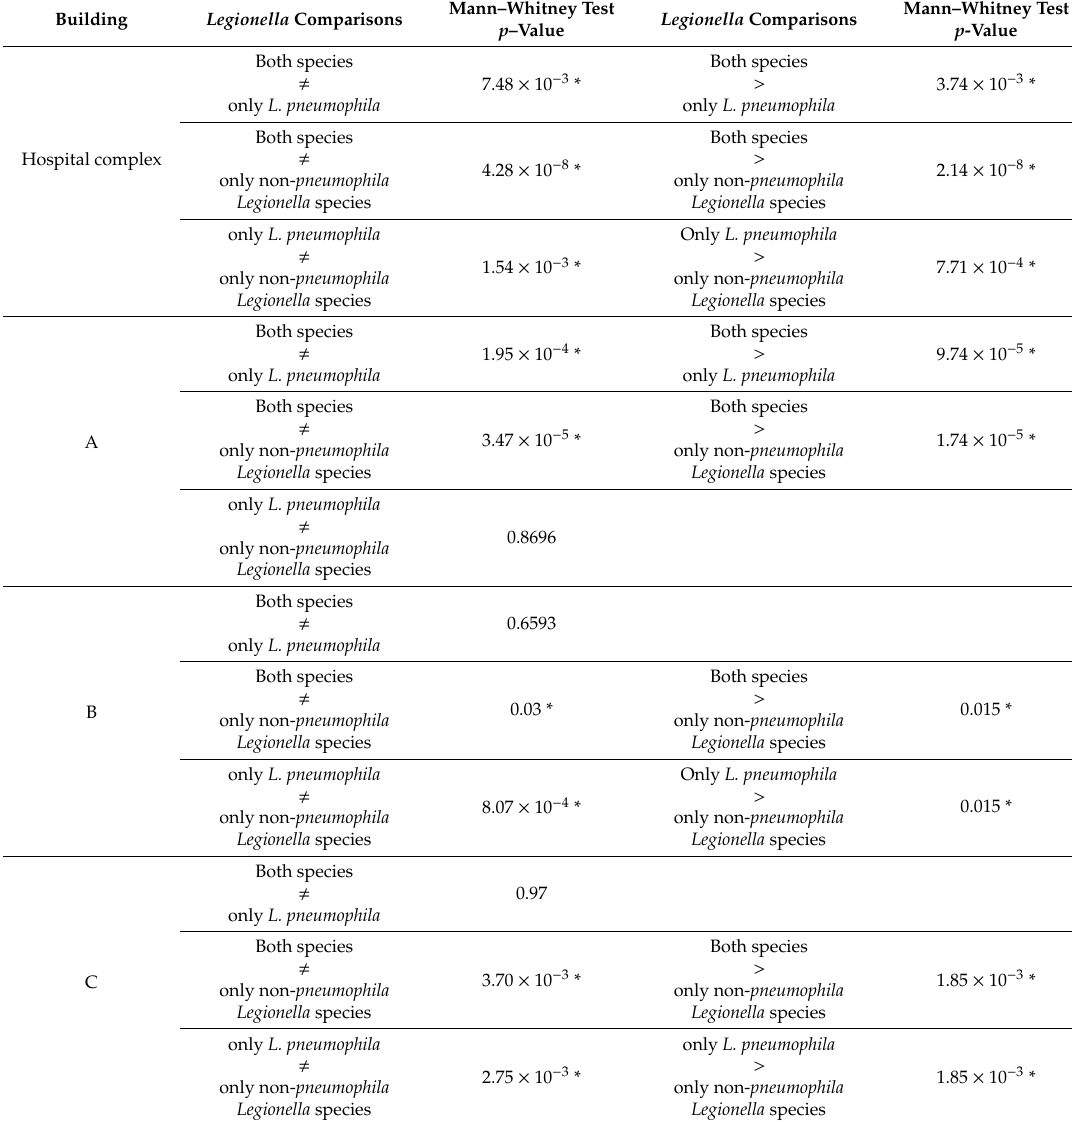
Table 5. Legionella mean concentration comparison in hospital complex and within